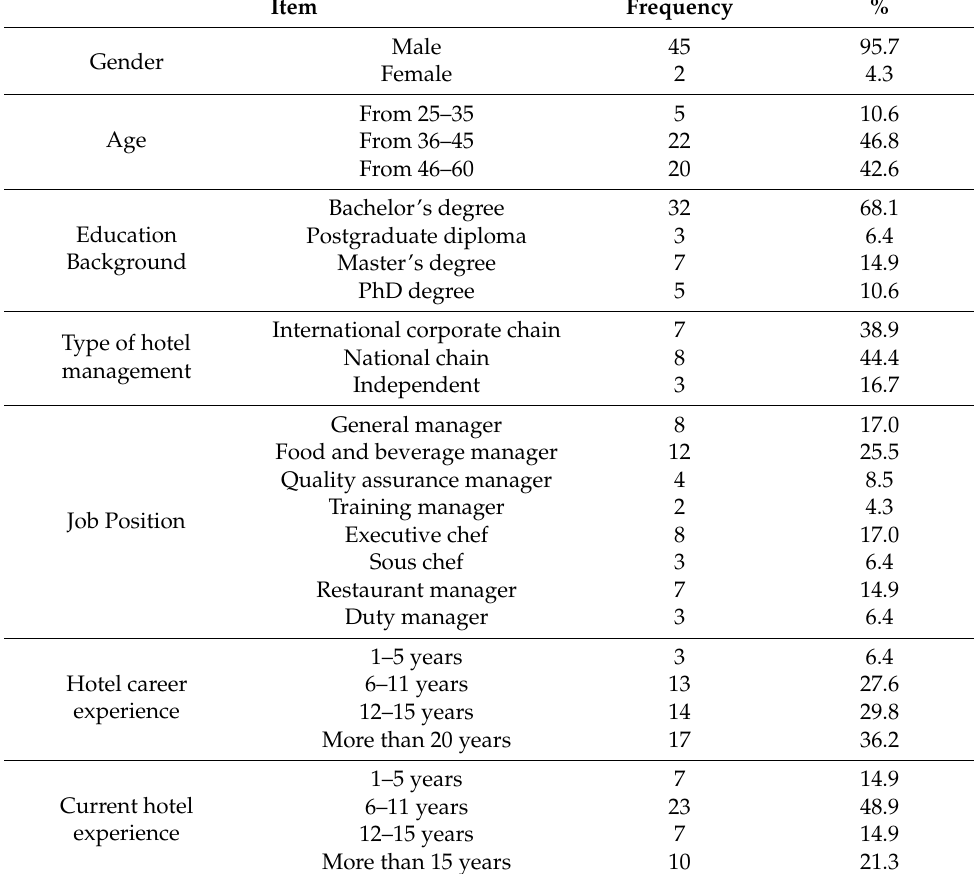
Table 2. Interviews profile ( n =